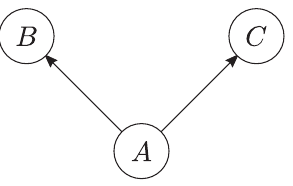
FIG. 3. A causal structure relating three quantum systems with A the complete common cause of B and C